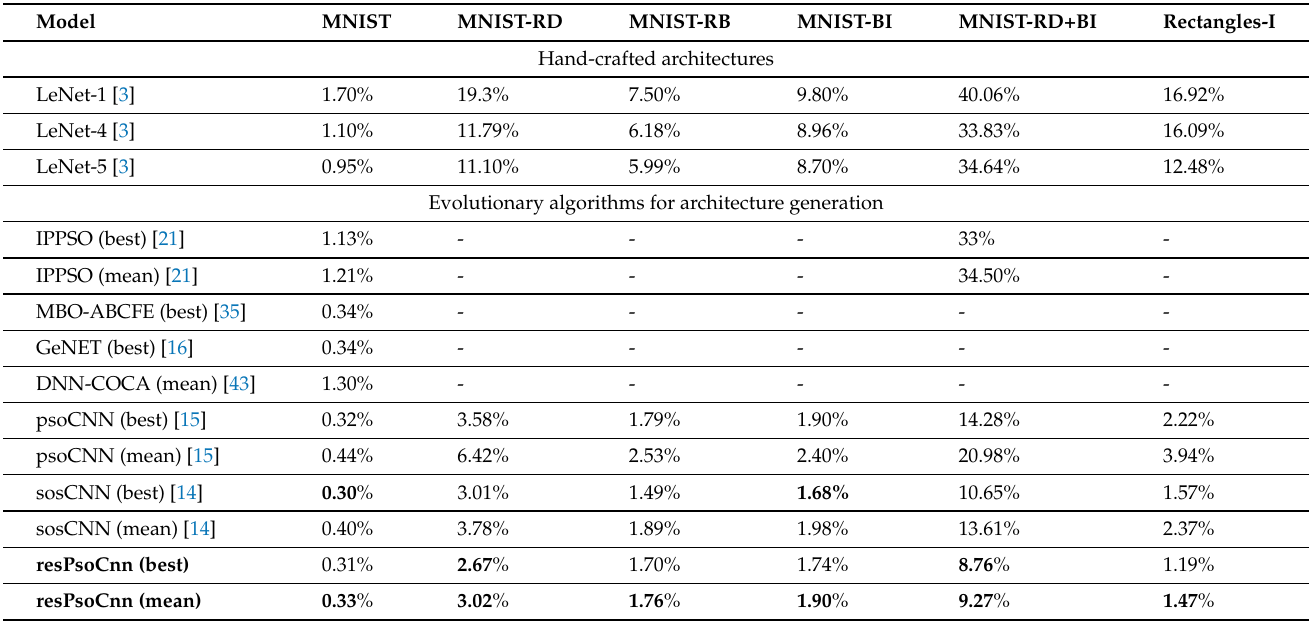
Table 5. Experimental results of the proposed model, resPsoCnn and those of the compared methods extracted from their original studies. The best results are highlighted in bold for a given dataset.